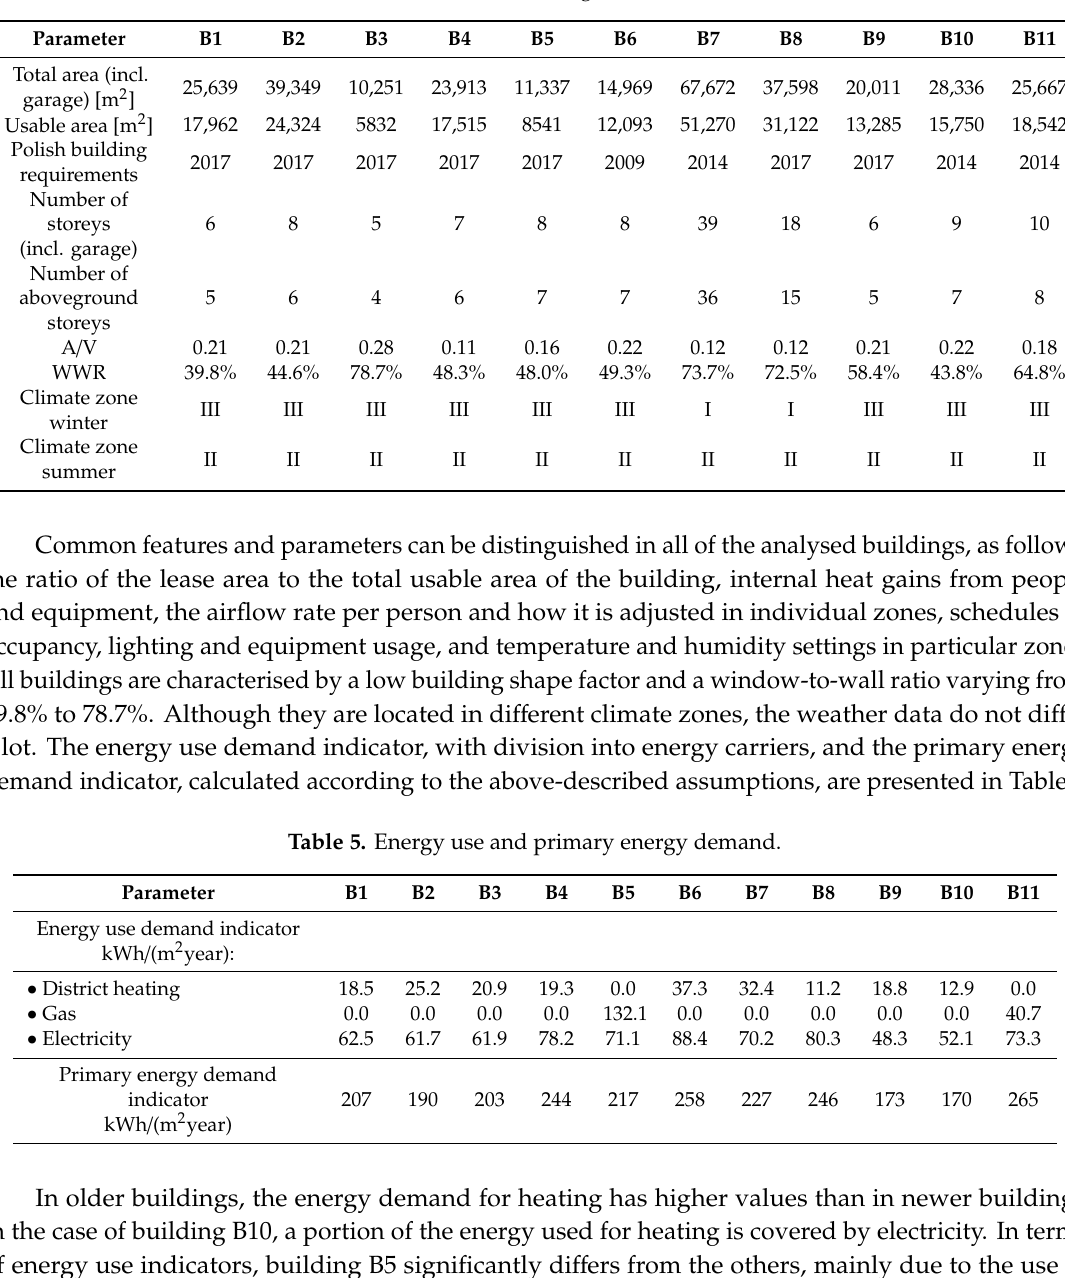
Table 4. General buildings information.